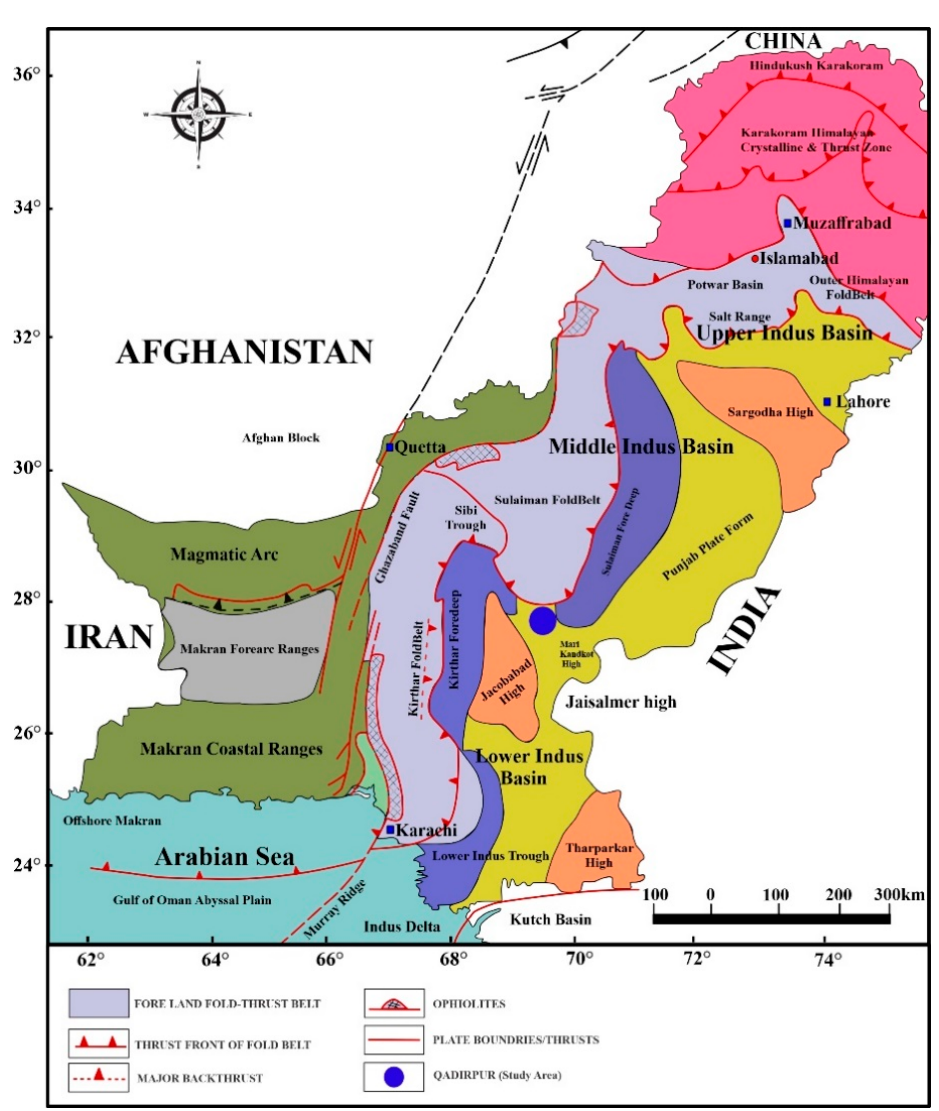
Figure 3. Tectonic map of the